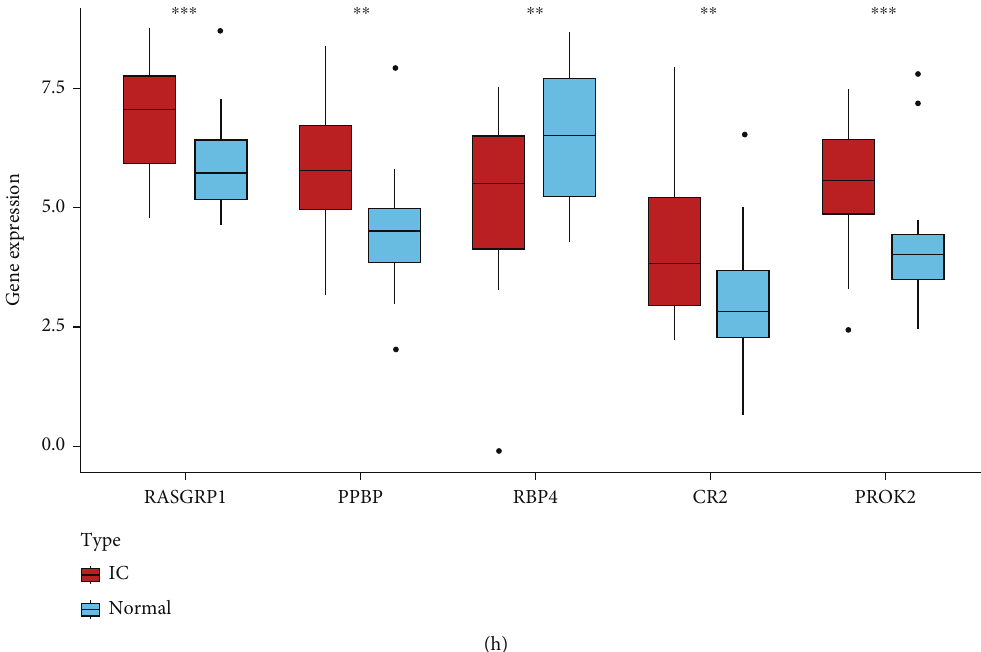
Figure 4: Establishment of nomogram and assessment of characteristic value. (a) Nomogram was constructed for diagnosing IC. (b) Calibration curve was plotted to evaluate the stability of the prediction results of the nomogram. (c – g) ROC curve was established to estimate the reliability and robustness of IC characteristic genes in the diagnosis of IC. (h) The box plot performs the expression of IC characteristic